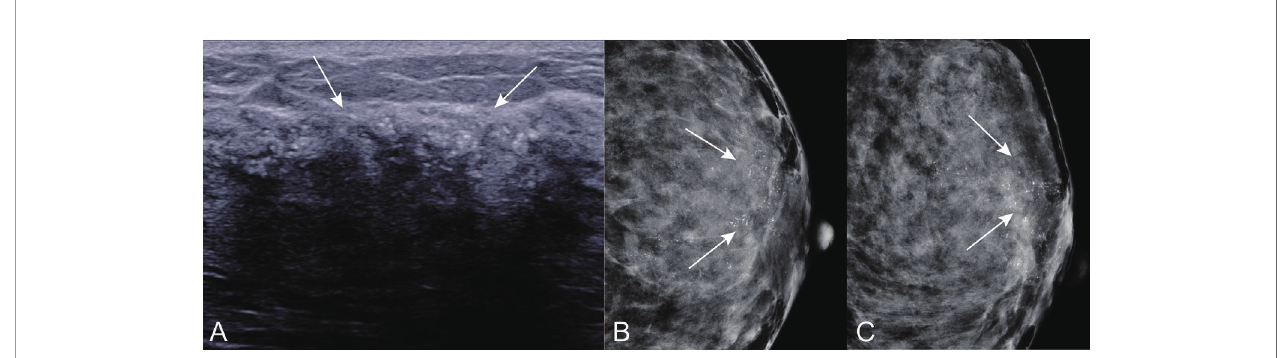
FIGURE 7 | Calci fi cations on US in patients with ADH on CNB. A 55 years old woman diagnosed with DCIS at fi nal pathologic examination. (A) US showed calci fi cations (arrow) around with hypoechoic non-mass of breast lesion. Corresponding mammogram showed grouping and indeterminate microcalci fi cations in CC position (B) and MLO position (C)